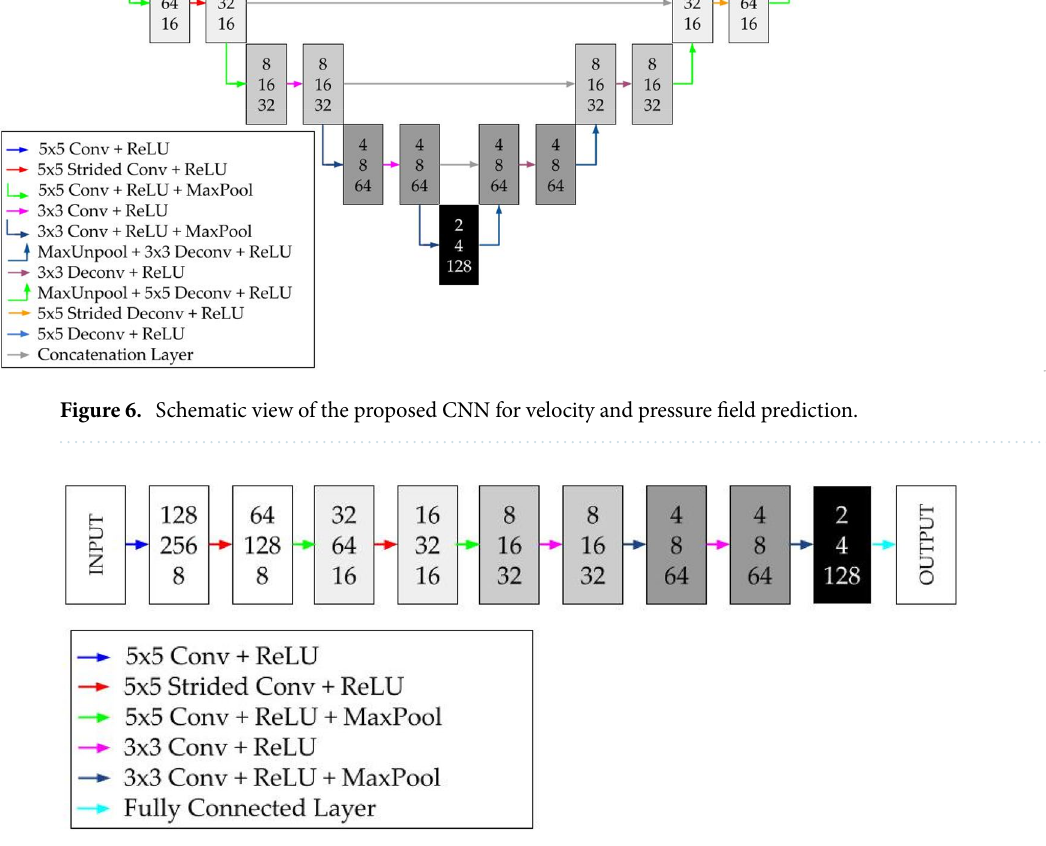
Figure 7. Schematic view of the proposed CNN for aerodynamic coefficient